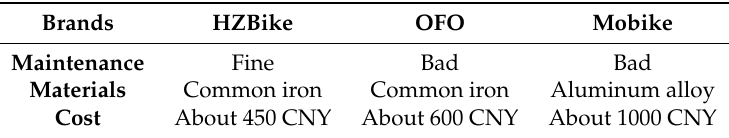
Table 6. Comparison on cost and maintenance of three brands